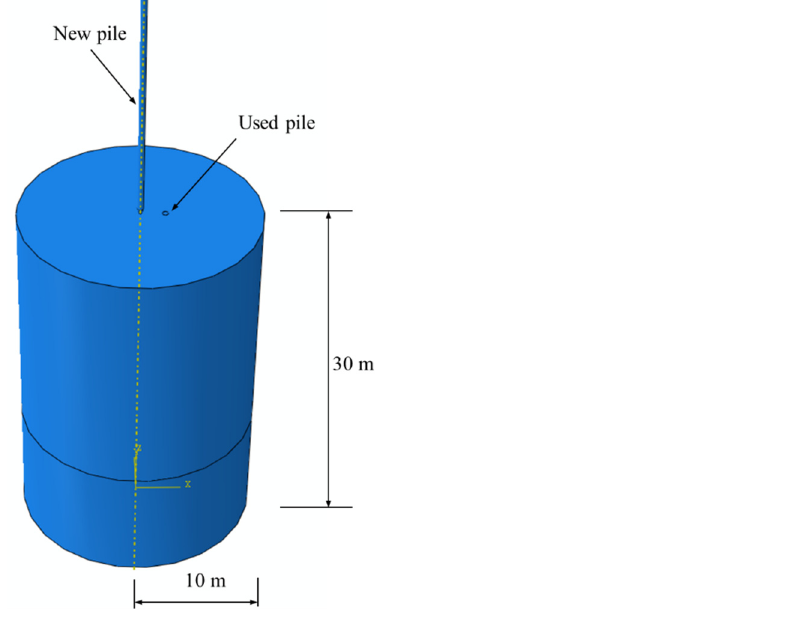
Figure 6. FEM model of new pile penetration with existing pile in stratum.